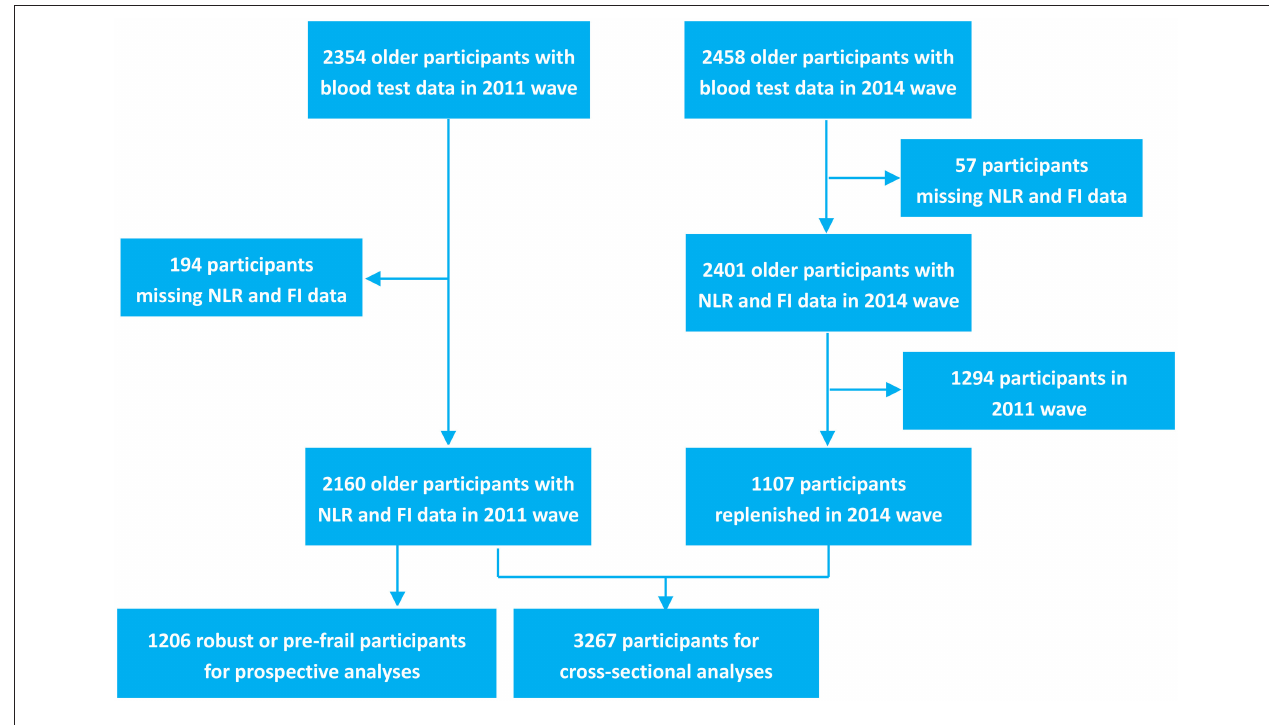
FIGURE 1 | Flowchart of the study identification process.